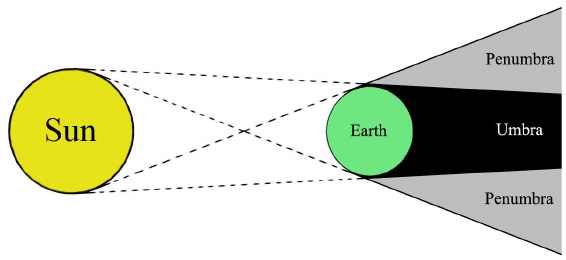
Figure 2: Umbra and Penumbra region of Earth-Sun